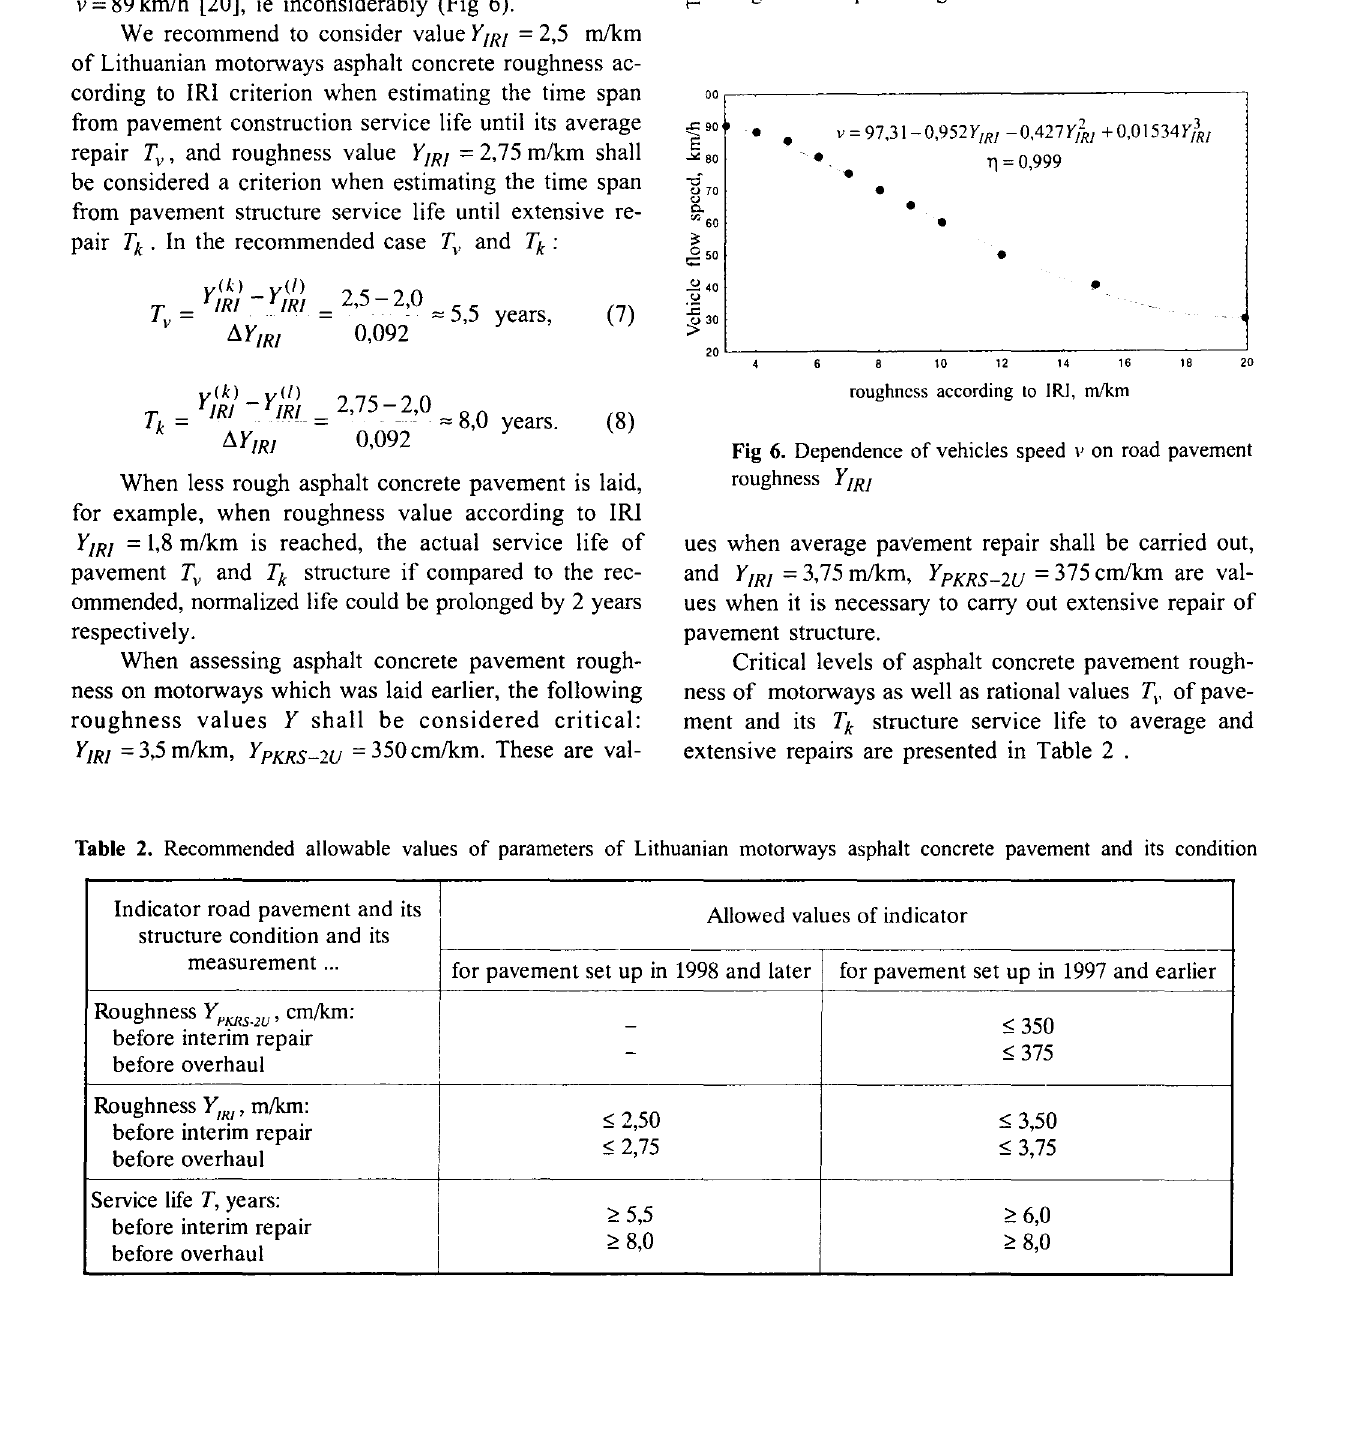
Fig 5. Interdependence of flatness YIRI of a road cover ing and transport charges I